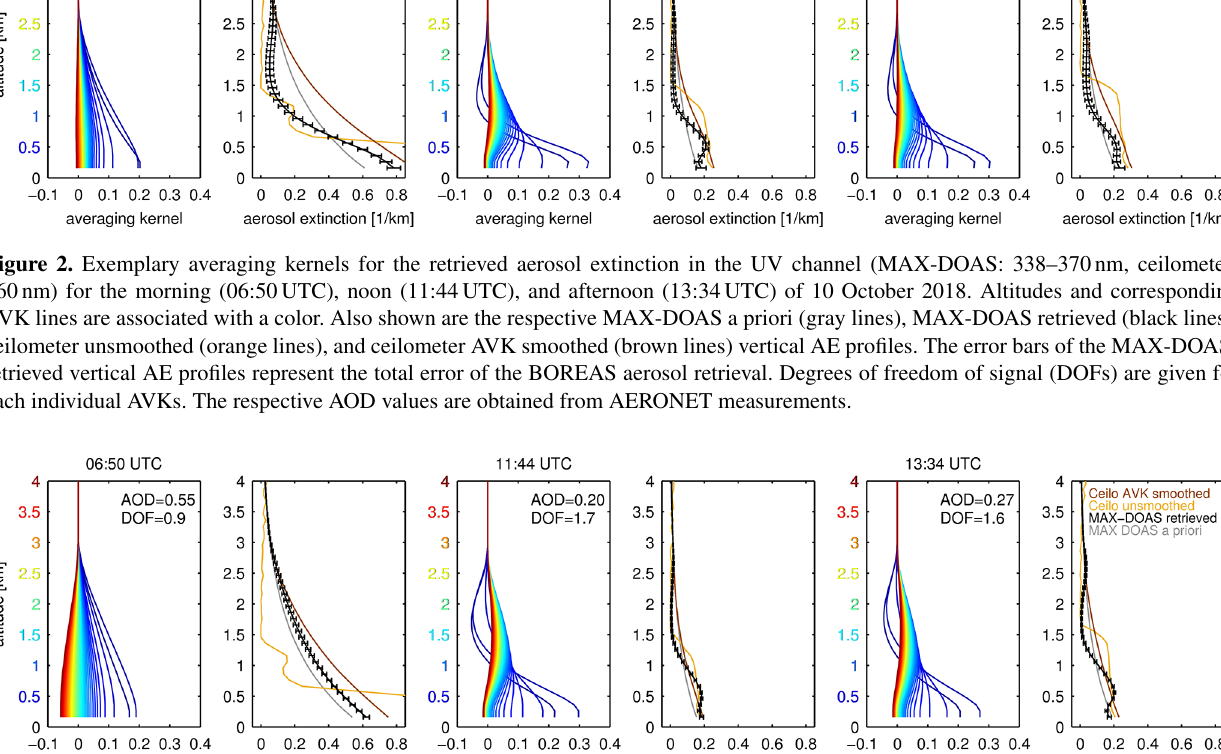
molecule (O 2 ) only depends on pressure and